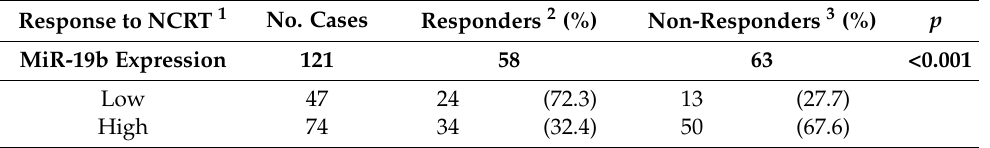
Table 2. Association between miR-19b expression levels and pathological response to neoadjuvant CRT in LARC patients.